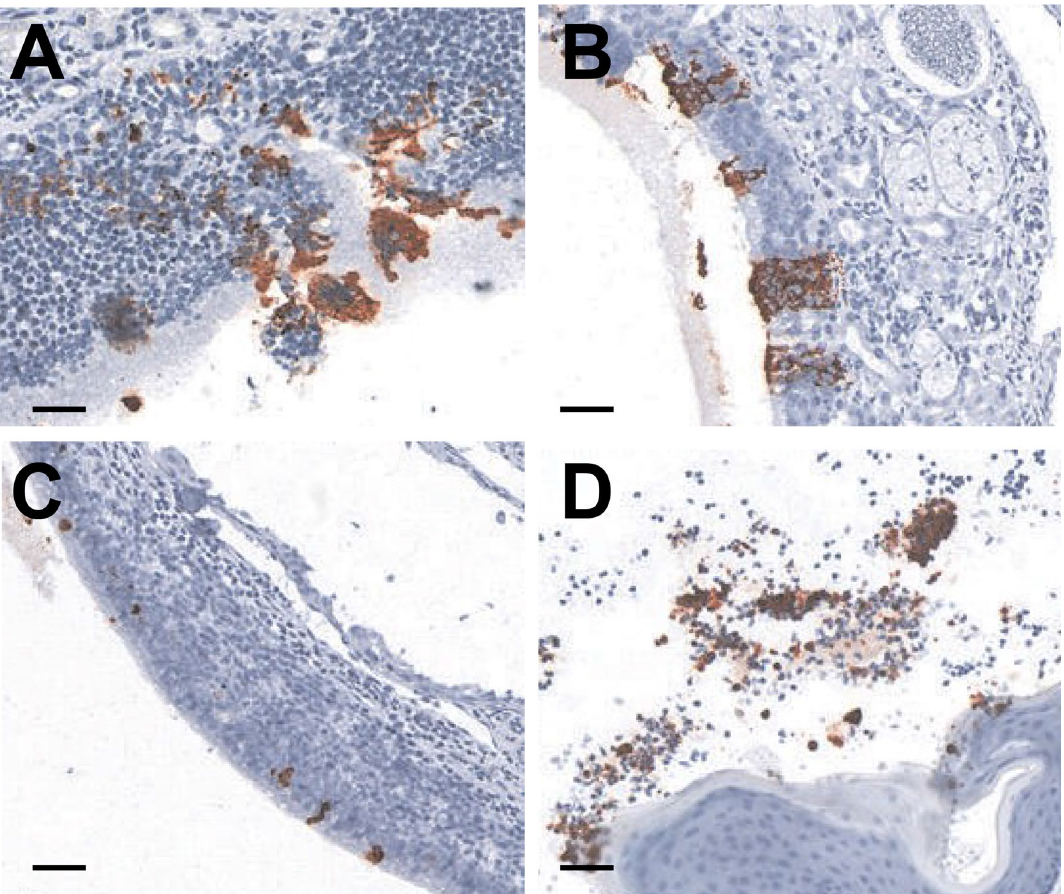
Figure 4. SARS-CoV-2 nucleocapsid IHC labeling in nasal turbinates. ( A ) Representative image from a ferret euthanased at day 3 post-inoculation (p.i.), intense positive cytoplasmic diffuse labeling in olfactory epithelium. ( B ) Day 5 p.i., small patches of positively labeled olfactory epithelium. ( C ) Day 7 p.i., scattered individual antigen-positive epithelial cells in the respiratory epithelium of the nasal turbinates. ( D ) Day 7 p.i., antigen- positive sloughed epithelial cells admixed with many inflammatory cells and mucus overlying the oropharyngeal mucosa. SARS-CoV-2 IHC sections are labelled with a nucleocapsid- specific polyclonal antibody, HRP- secondary antibody and aminoethyl carbazole chromagen. Scale bars in each panel represent 50 µm.